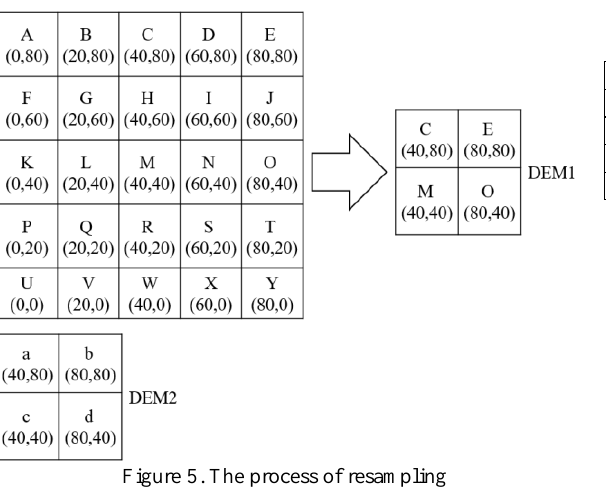
Figure 5. The process of resampling